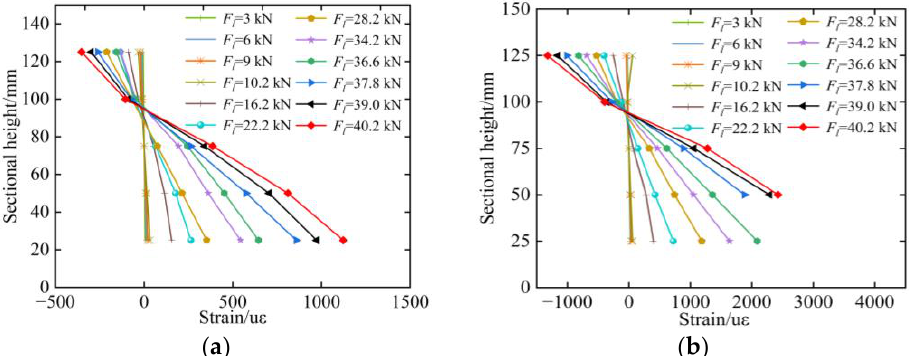
Figure 14. Section strain distribution along the test pile. ( a ) CSG-1; ( b )